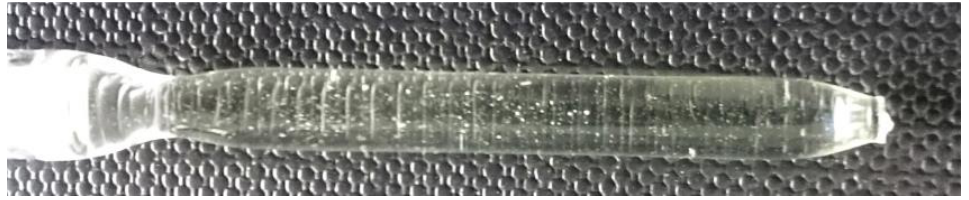
Figure 4. Vitrified core rod after vitrification treatment (diameter < 5 mm) [7].